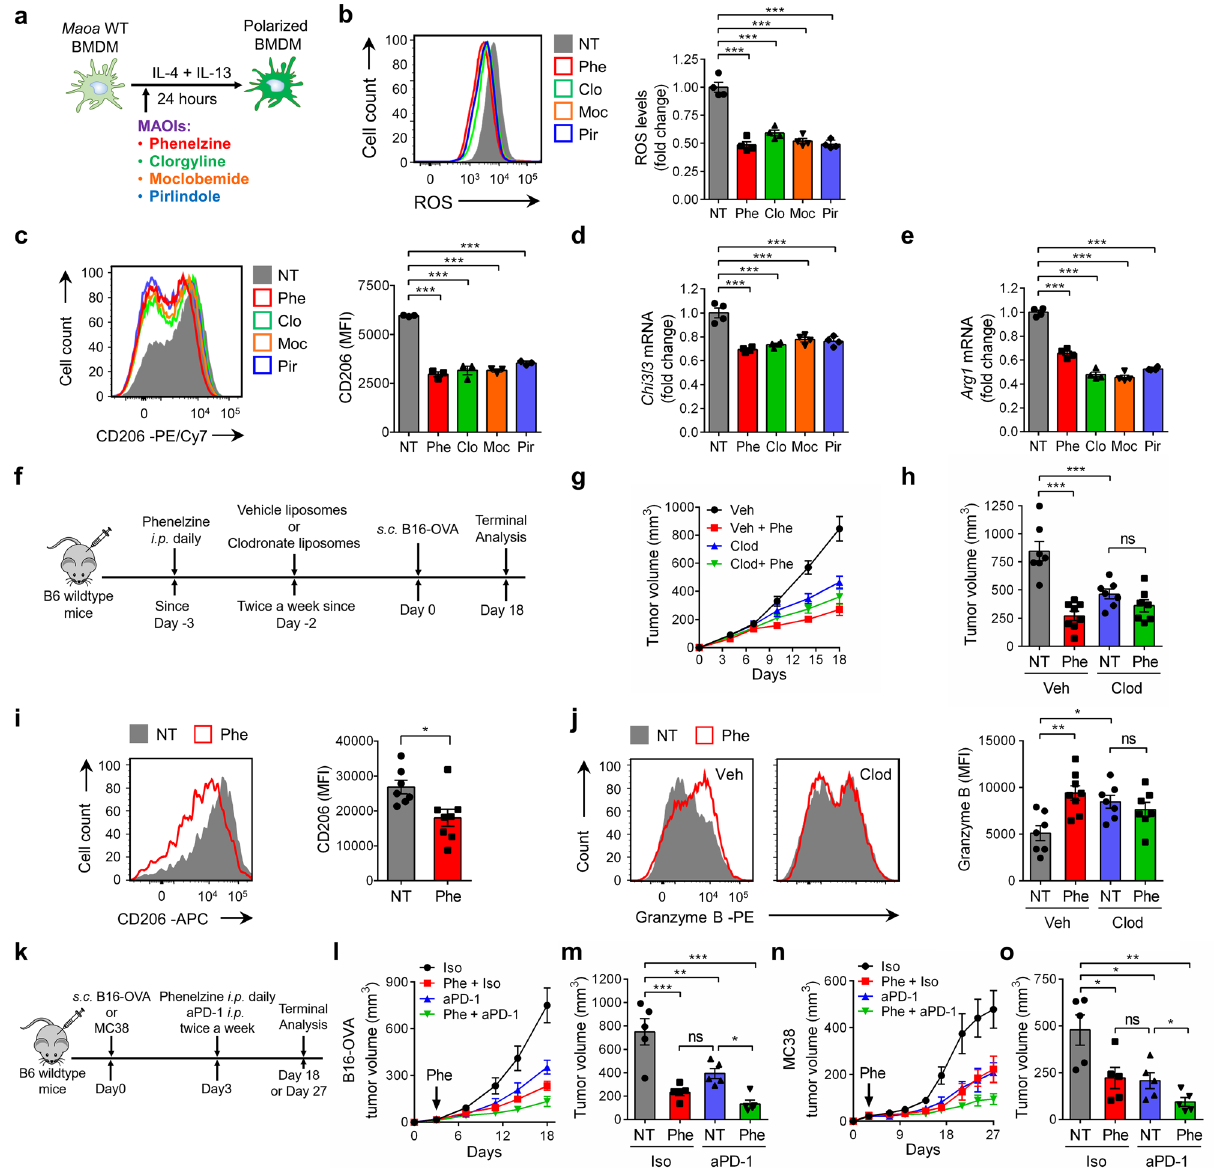
Fig. 5 MAO-A blockade for cancer immunotherapy — syngeneic mouse tumor model studies. a – e Studying the effect of MAOI treatment on IL-4/IL-13- induced BMDM polarization in vitro ( n = 4). a Experimental design. Wild-type BMDMs were stimulated with IL-4/IL-13 with or without MAOI treatment. MAOIs (monoamine oxidase inhibitors) studied were phenelzine (Phe; 20 μ M), clorgyline (Clo; 20 μ M), moclobemide (Moc; 200 μ M), and pirlindole (Pir; 20 μ M). NT no MAOI treatment. b FACS analyses of ROS levels in BMDMs. c FACS analyses of CD206 expression on BMDMs. d , e QPCR analyses of Chi3l3 ( d ) and Arg1 ( e ) mRNA expression in BMDMs. *** p < 0.001. f – j Studying the TAM-related cancer immunotherapy potential of MAOI treatment in a B16-OVA melanoma syngeneic mouse tumor model. f Experimental design. B6 wild-type mice were treated with clodronate liposomes (Clod) to serve as TAM-depleted experimental mice or treated with vehicle liposomes (Veh) to serve as TAM-intact control mice. Phe phenelzine treatment, NT no phenelzine treatment. g Tumor growth. h Tumor volume at day 18 (*** p < 0.001). i FACS analyses of CD206 expression on TAMs of TAM-intact experimental mice (* p = 0.0164). j FACS analyses of intracellular Granzyme B production in tumor-in fi ltrating CD8 + T cells of all experimental mice (NT, * p = 0.0257; Veh, ** p = 0.0025). Veh NT, n = 7; Veh Phe, n = 8; Clod NT, n = 7; Clod Phe, n = 7. k – o Studying the cancer therapy potential of MAOI treatment in combination with anti-PD-1 treatment in the B16-OVA melanoma and MC38 colon cancer syngeneic mouse tumor models ( n = 5). k Experimental design. Tumor-bearing mice were treated with anti-PD-1 antibody (aPD-1) or isotype control (Iso), together with or without phenelzine (Phe) treatment. NT no Phe treatment. l B16-OVA tumor growth. m B16-OVA tumor volume at day 18. n MC38 tumor growth. o MC38 tumor volume at day 27. * p < 0.05, ** p < 0.01 and *** p < 0.001. Representative of three experiments. Analysed by one-way ANOVA ( b – e , h , j , m , o ) or by Student ’ s t test ( i ). Statistics are all two-sided. Source data are provided as a Source Data fi